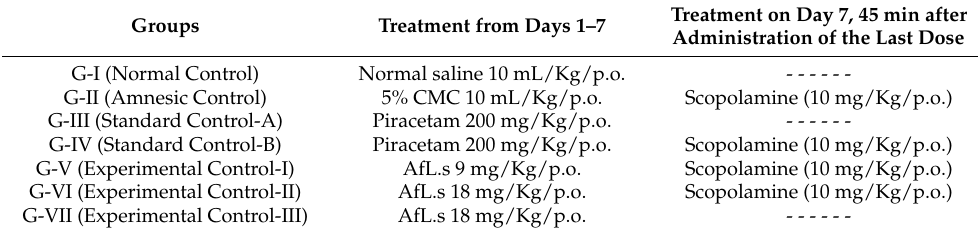
Table 1. Study design for behavioral and biochemical studies.